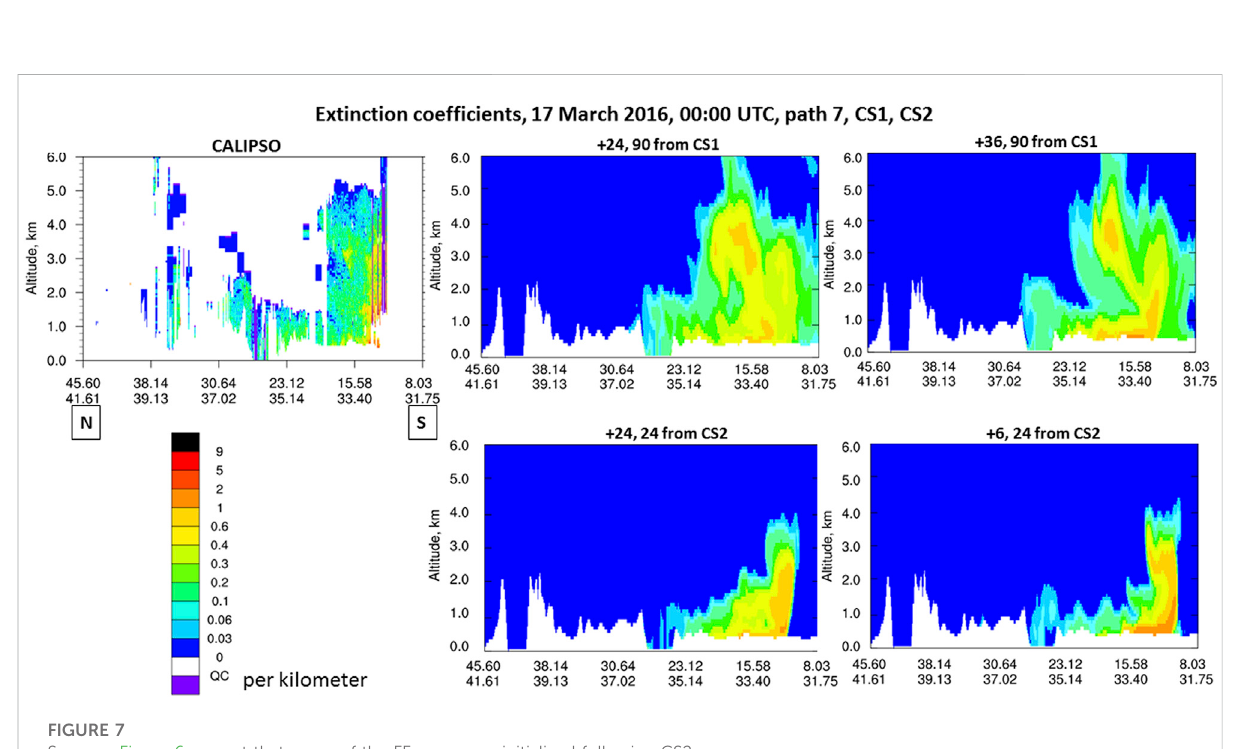
FIGURE 7 Same as Figure 6, except that some of the FF runs were initialized following